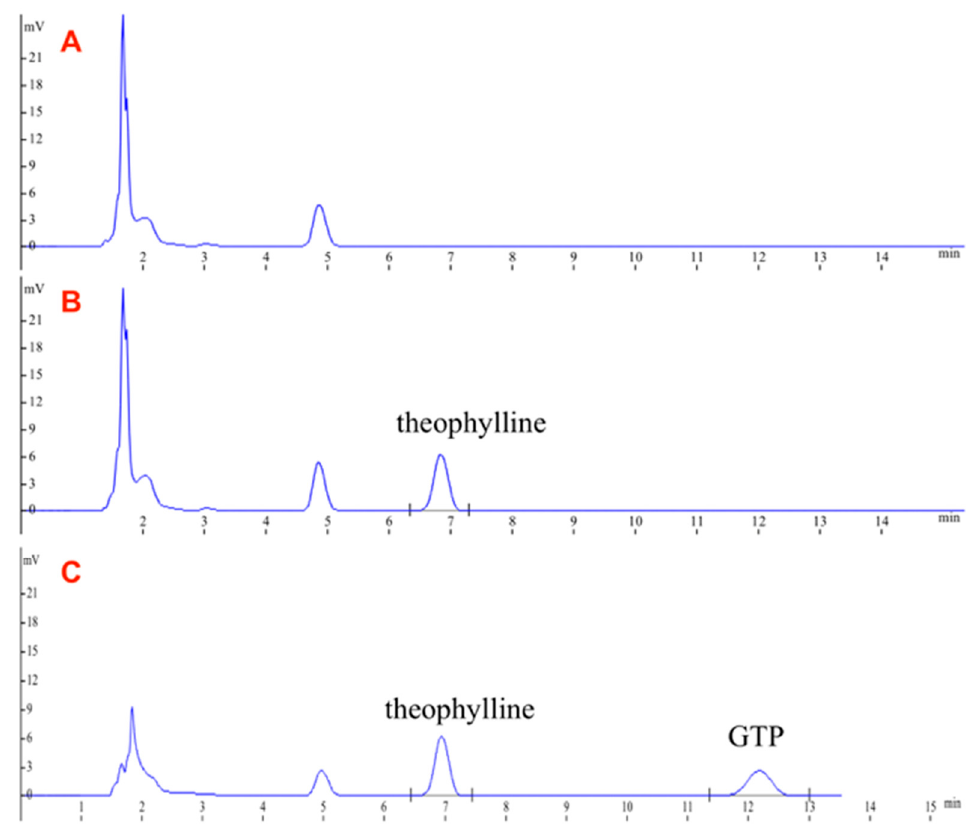
Figure 6. Typical chromatograms of ( A ) blank rat plasma; ( B ) blank rat plasma with theophylline; ( C ) blank rat plasma with theophylline and GTP.